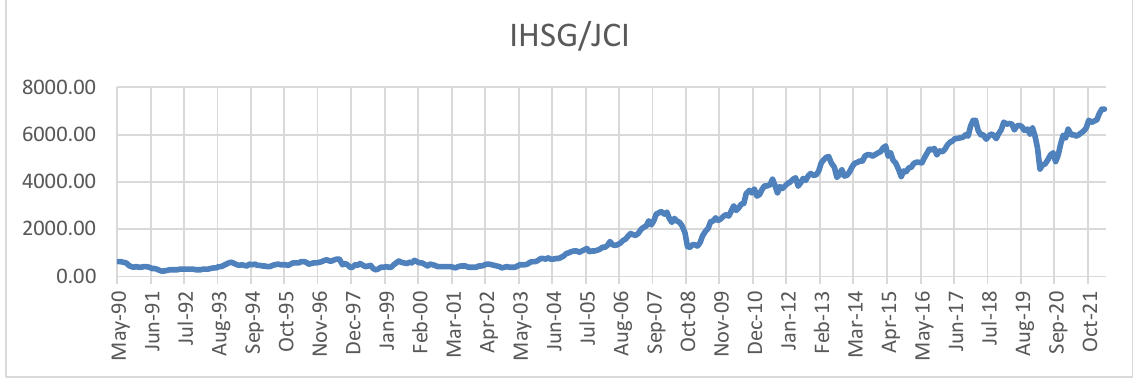
Figure 1: JCI Growth during May 1990 – April